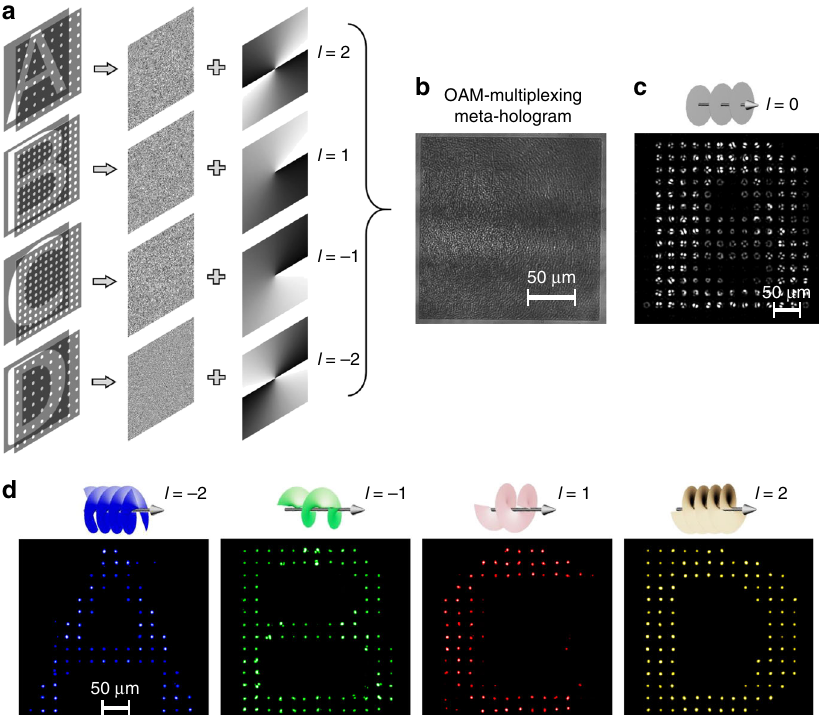
Fig. 4 Design and experimental characterization of an OAM-multiplexing meta-hologram capable of the lensless reconstruction of multiple distinctive OAM-dependent holographic images. a The design approach of an OAM-multiplexing hologram. b The optical image of a fabricated OAM-multiplexing meta-hologram based on the design in a . c The reconstruction of a complex interference pattern from the OAM-multiplexing meta-hologram through an incident beam with a planar wavefront. d Experimental reconstruction of four distinctive OAM-dependent holographic images through incident OAM beams with topological charges of l = − 2, − 1, 1, 2,